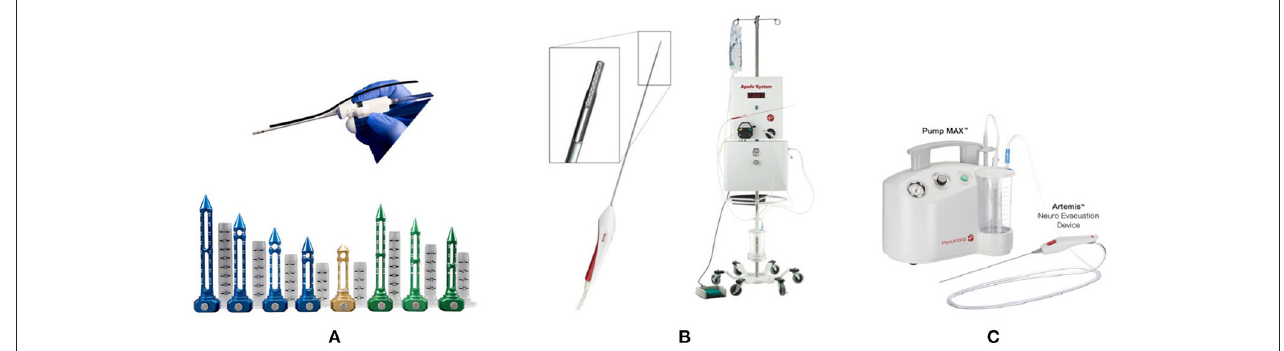
FIGURE 3 | Emerging minimally invasive instruments. (A) NICO BrainPath system and myriad handpiece (NICO Corp, Indianapolis, IN, USA). (B) The Apollo system. The Wand and aspiration–irrigation system (Penumbra Inc, Alameda, CA, USA). (C) The Artemis Neuro Evacuation Device and Pump MAX TM aspiration system (Penumbra, Alameda, CA,